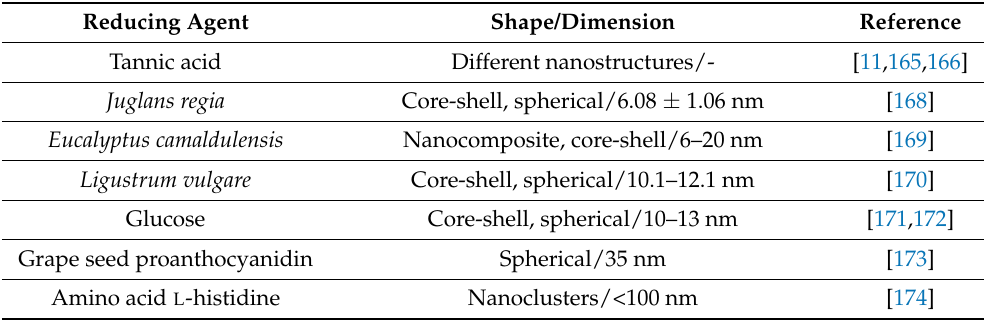
Table 2. Magneto-plasmonic heterostructures produced using green approaches. Reducing Agent